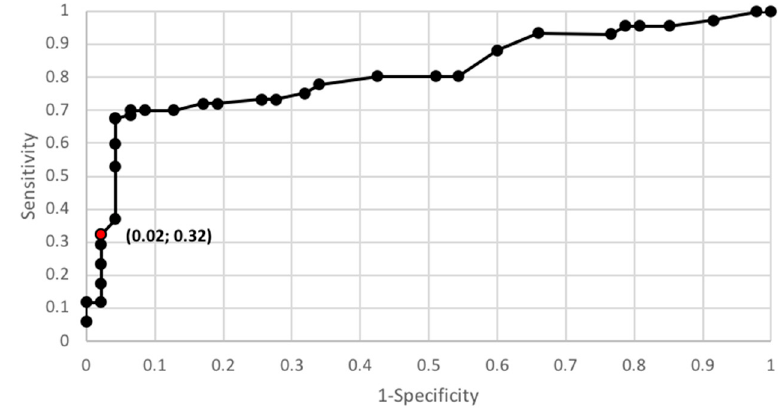
Figure 1. Galectin 3 protein ROC curve depending on grading (AUC = 0.9).